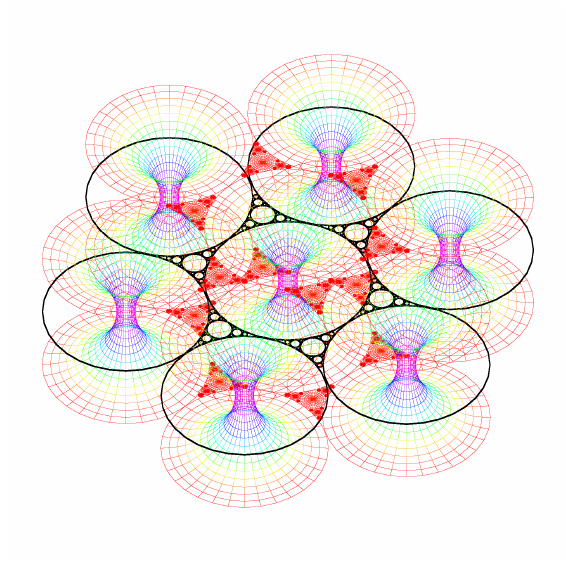
lines that are the circles and their cofocal straight lines. The Apollonius tiling corresponding to these singular lines appears always in black color. Finally, some picture of the smectic layers with some